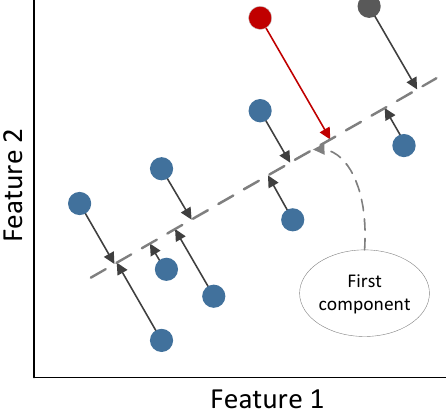
Figure 3. Representation of PCA for one